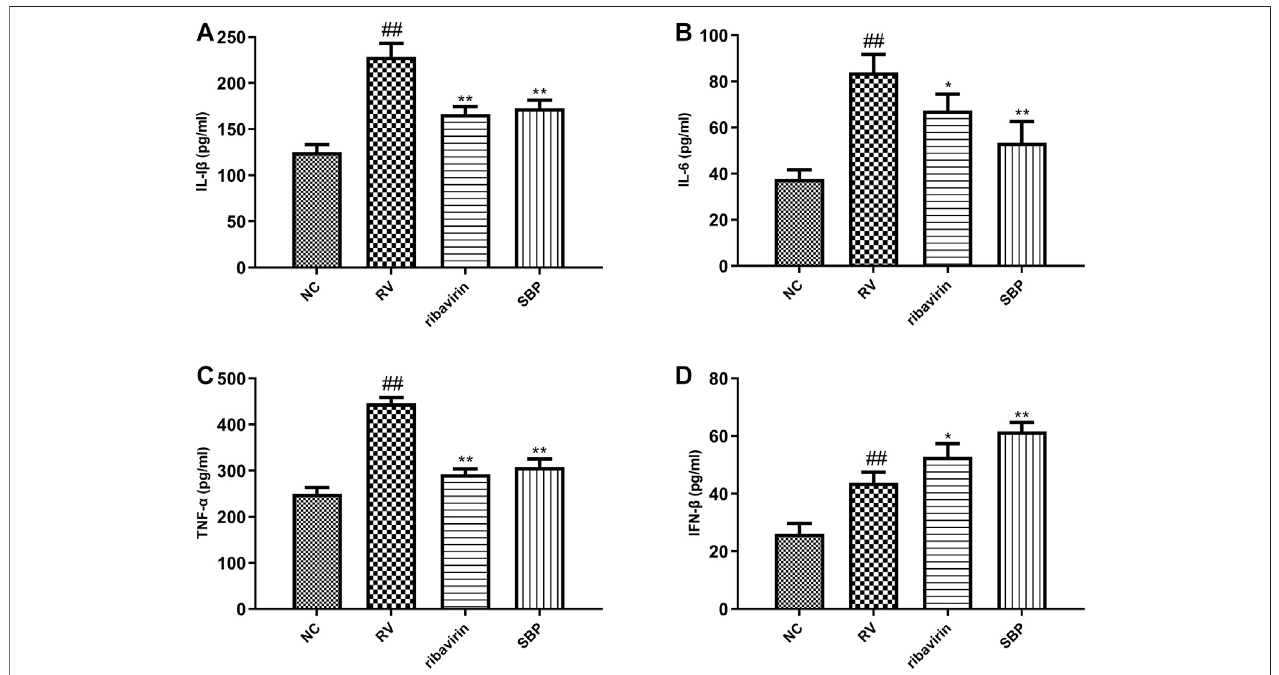
FIGURE 5 | The expression of cytokines detected using ELISA ( n (cid:2) 3). All values were presented as mean ± SD. ## p < 0.01 vs. NC group; * p < 0.05, ** p < 0.01 vs. RV group.